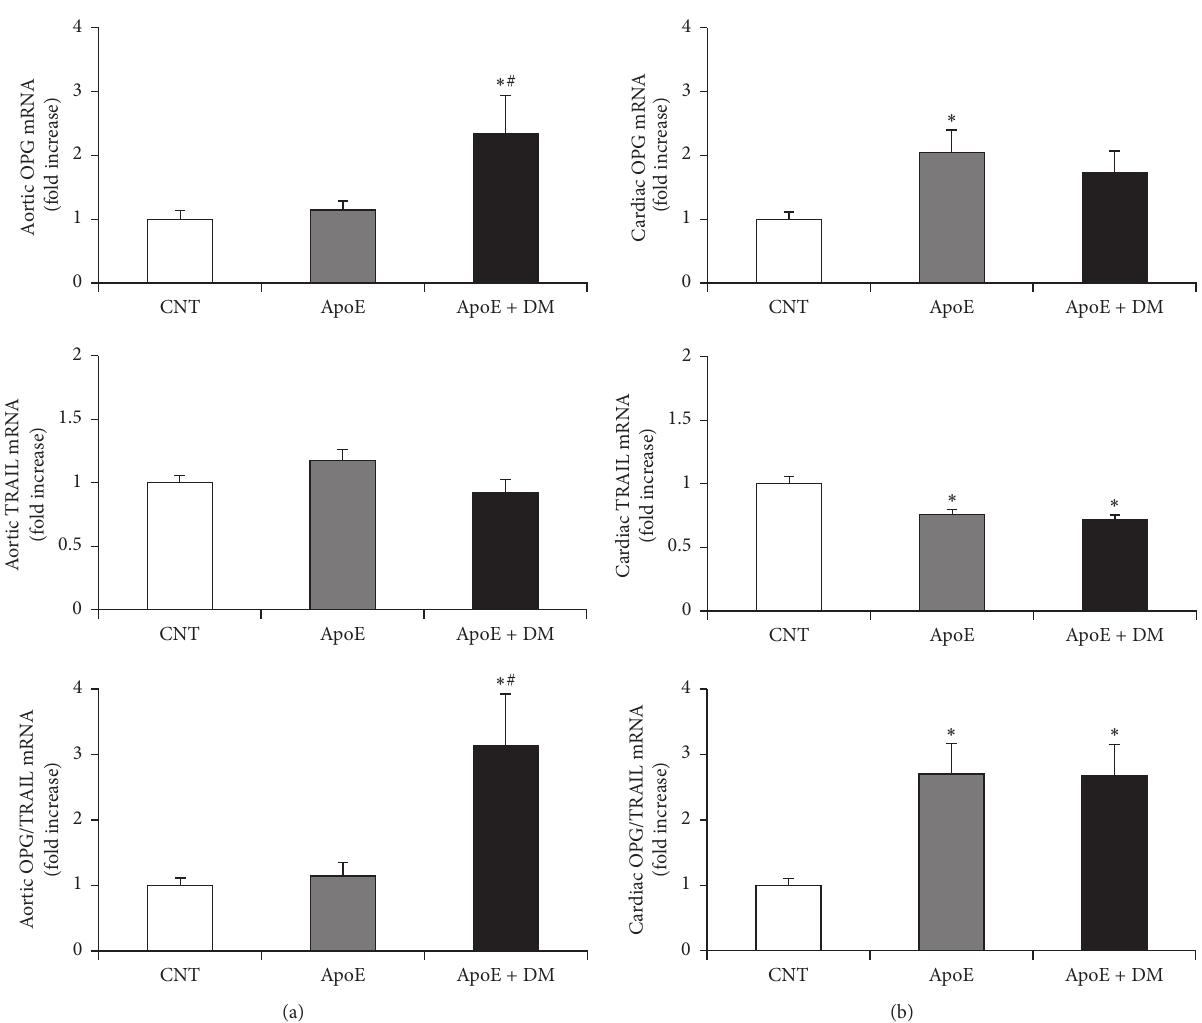
Figure 2: Effect of dyslipidemia and diabetes on OPG, TRAIL gene expression, and OPG/TRAIL ratio in the aorta and the heart. (a) Aortic messenger RNA expression of OPG, TRAIL, and OPG/TRAIL ratio, reported as relative gene units. (b) Cardiac messenger RNA expression of OPG, TRAIL, and OPG/TRAIL ratio, reported as relative gene units. Data are expressed as mean ± SEM. ∗ 𝑝 < 0.05 versus CNT; # 𝑝 < 0.05 versus ApoE. CNT is for C57BL/6J mice; ApoE is for ApoE −/− mice; ApoE + DM is for ApoE −/− mice + diabetes